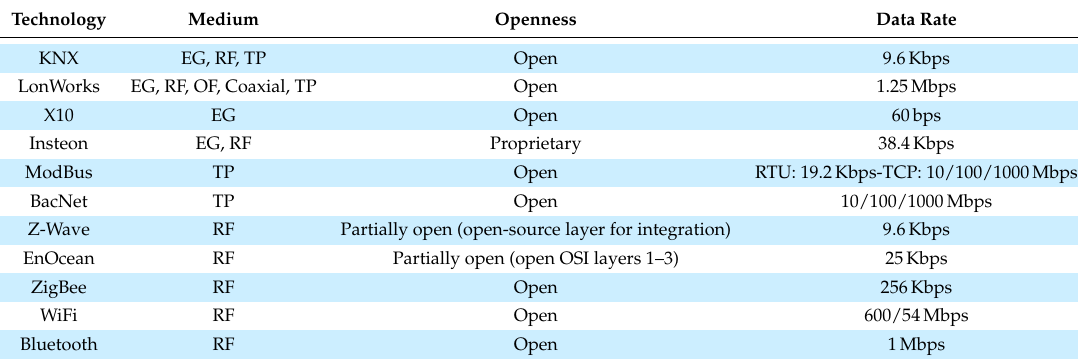
Table 1. Characteristics of the most common home automation technologies. RF: Radio Frequency, EG: Electric Grid, OF: Optical Fiber, TP: Twisted